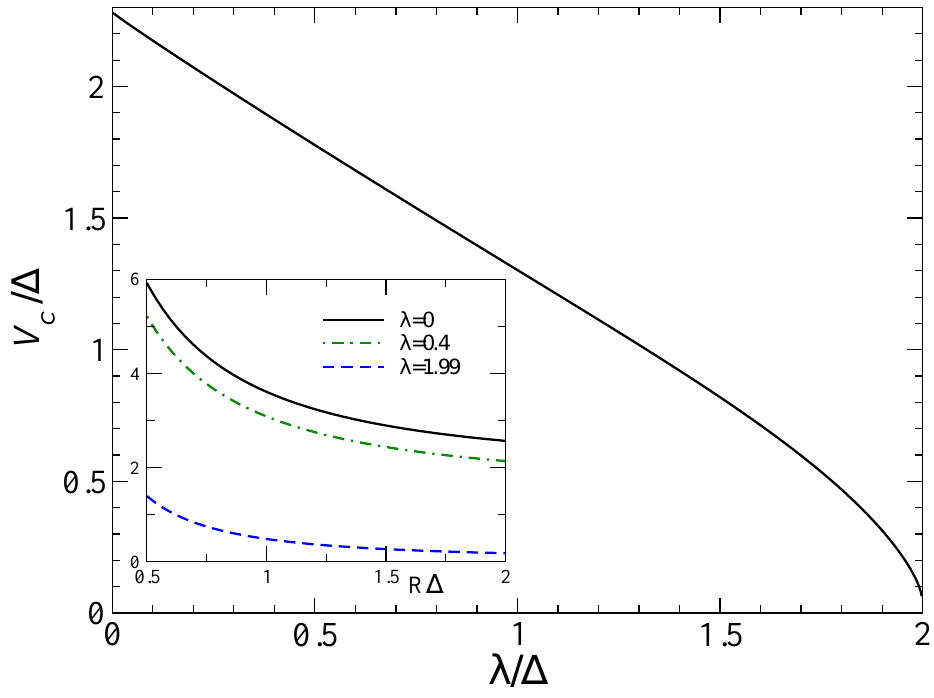
Figure 2. Critical potential depth V for the lowest j = 1 bound state level in a disk with c R ∆ = 3 . The obtained λ = 0 value matches the analytical prediction V → 0 near the border of the TI phase ( λ → 2∆ ). Inset: V Equation (31), while V c R with several values of λ (given in units of ∆ ) for the lowest bound